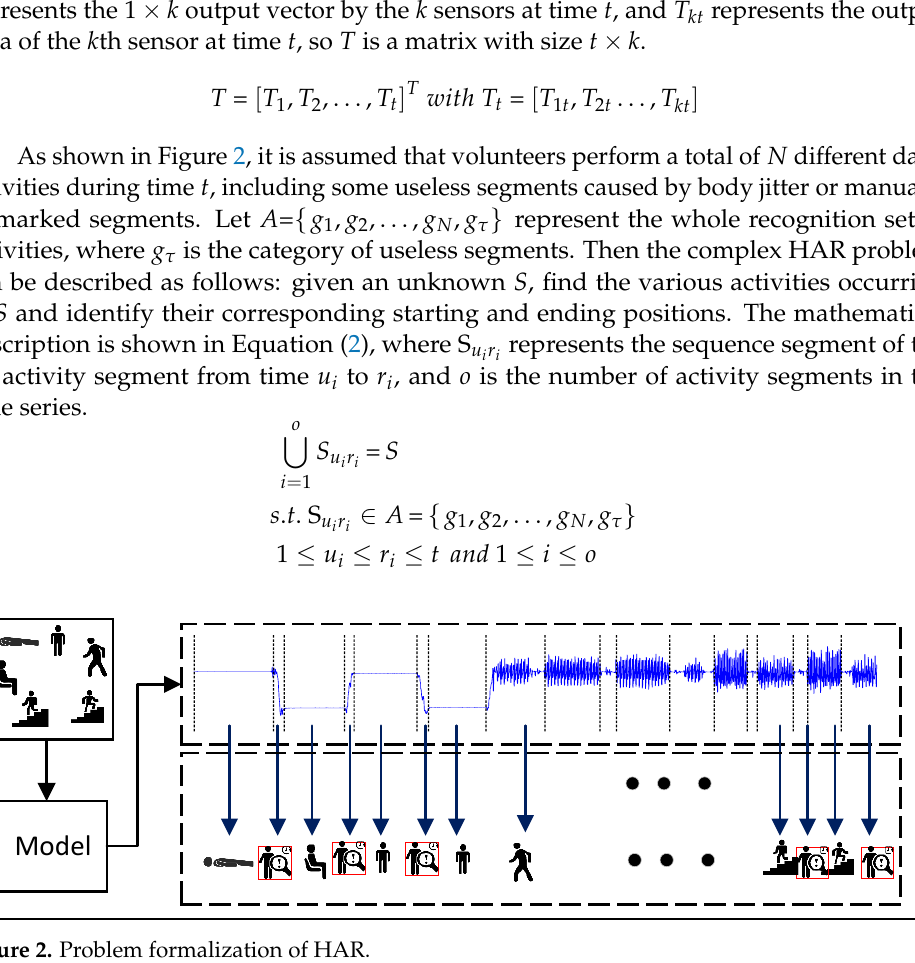
Figure 2. Problem formalization of